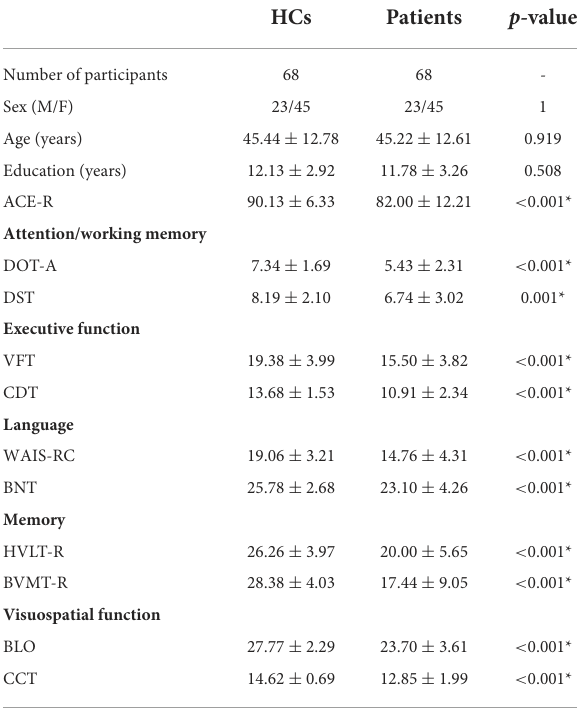
TABLE 2 Comparison between patients and